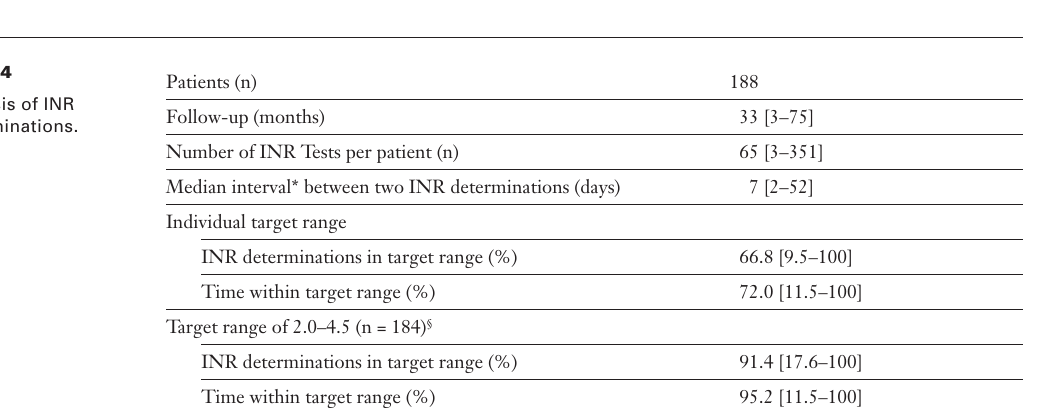
Analysis of INR